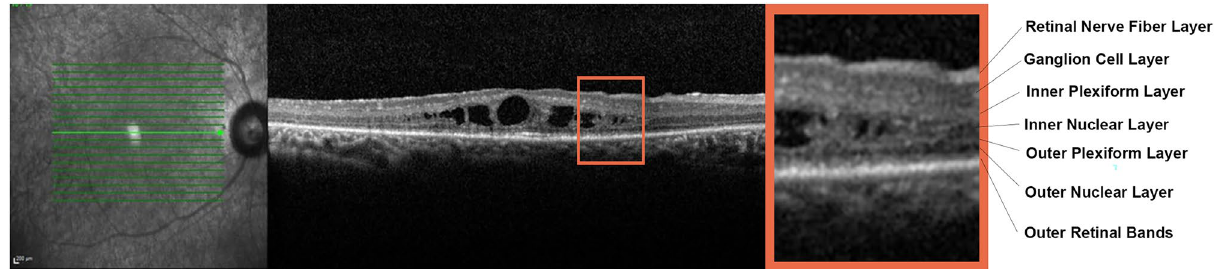
Figure 2. Macular edema localization in retinitis pigmentosa. The magnified image identifies each retinal layer and detects macular edema mainly localized in the inner nuclear layer.